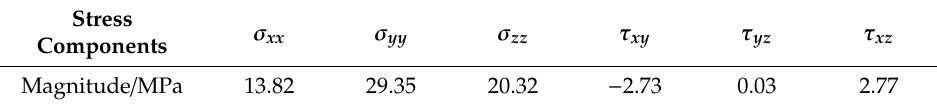
Table 2. Diametral displacements at different angles for the first borehole (Unit: mm).